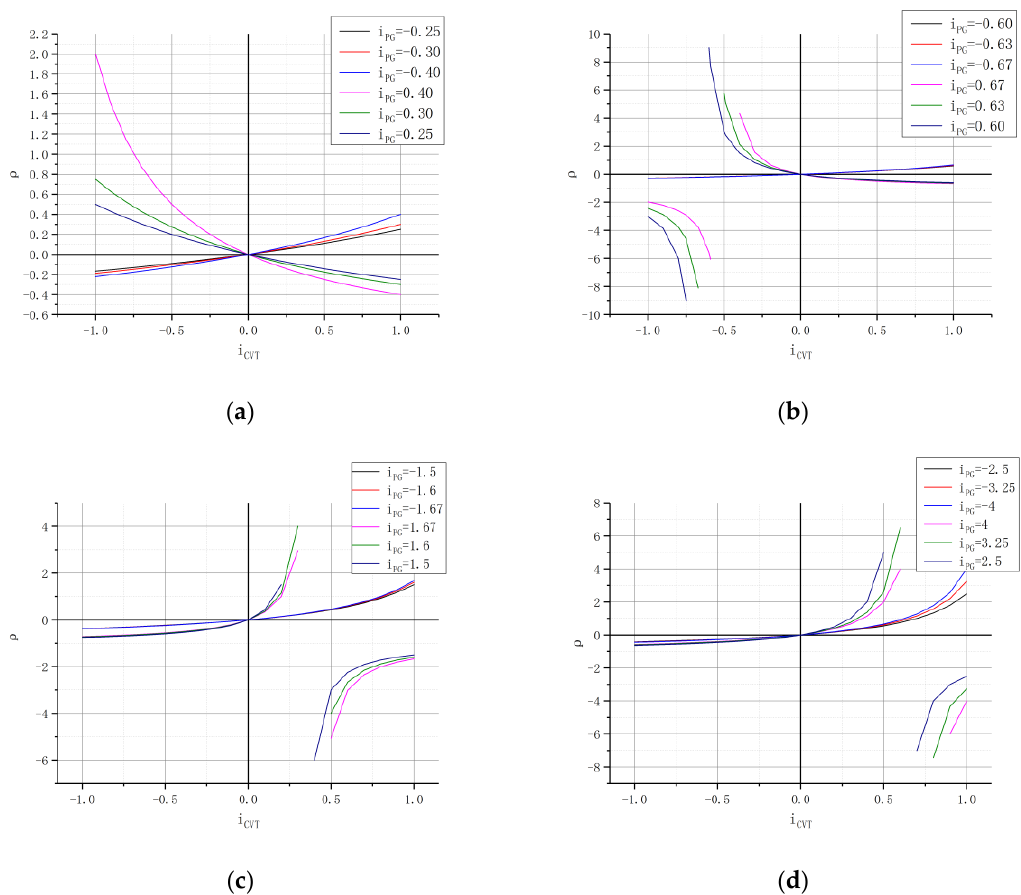
Figure 11. The hydrostatic power proportion, ρ , in four matching patterns. ( a ) The hydrostatic power proportion pattern a; ( b ) The hydrostatic power proportion pattern b; ( c ) The hydrostatic power proportion pattern c; ( d ) The hydrostatic power proportion pattern d.